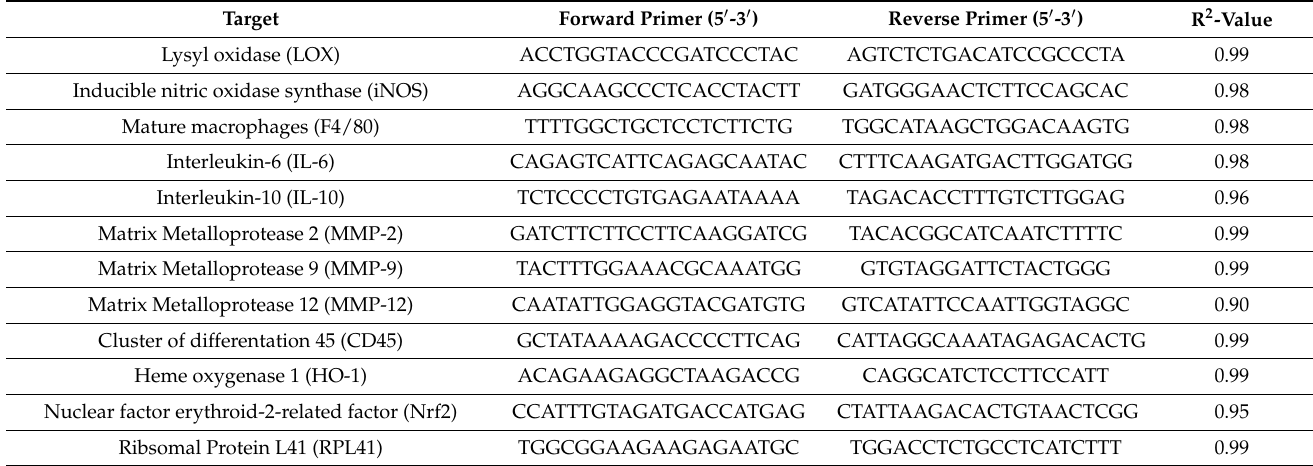
Table 1. Primer sequences for qPCR analyses. The coefficient of correlation obtained for the standard curve expressed as R 2 -value is stated for each PCR